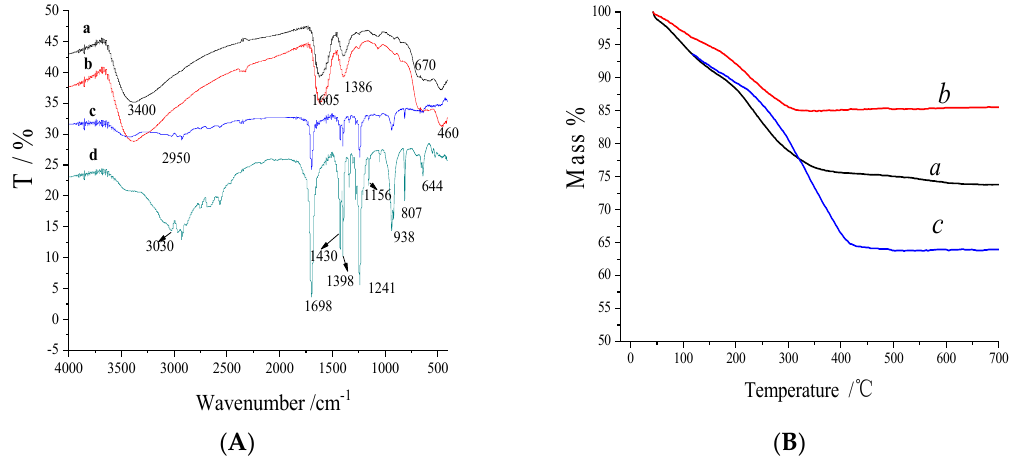
Figure 3. FTIR spectra ( A ) of Fe 3 O 4 NPs (a), Fe 3 O 4 @Au NPs (b), Fe 3 O 4 @Au-COOH NPs (c), Fe 3 O 4 @Au@PDA MNPs (d), TGA curves ( B ) of Fe 3 O 4 NPs (a), Fe 3 O 4 @Au NPs (b), Fe 3 O 4 @Au@PDA MNPs (c).